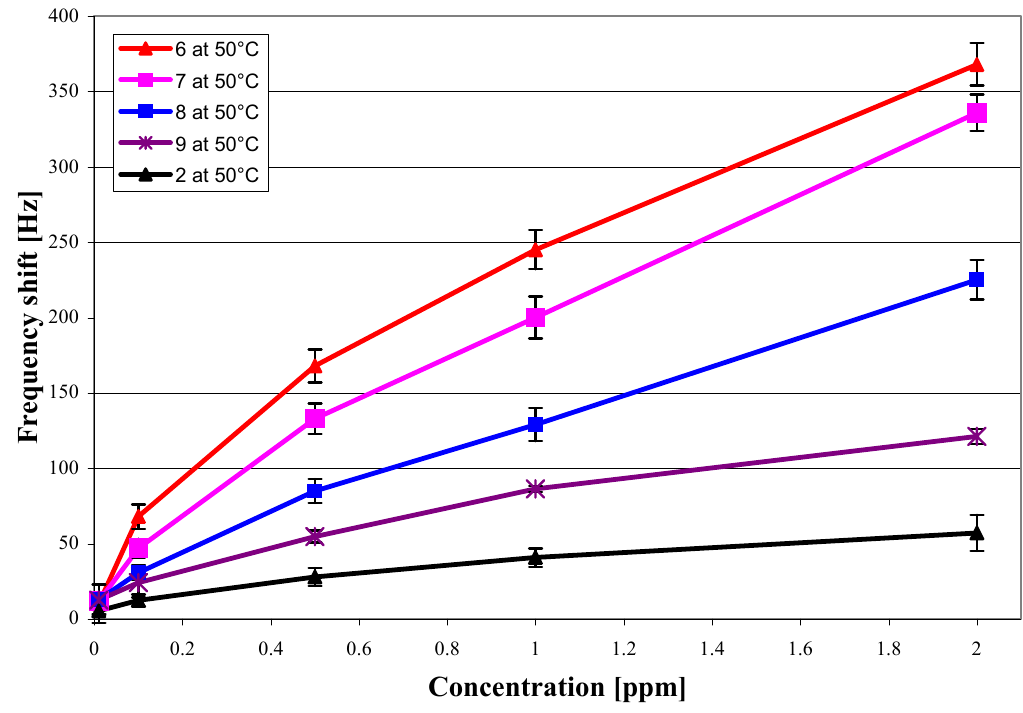
Figure 4. Characteristic frequency difference/concentration profiles of the tetralactam macrocycles 6 - 9 examined in this study including the open-chain extended diamine 2.